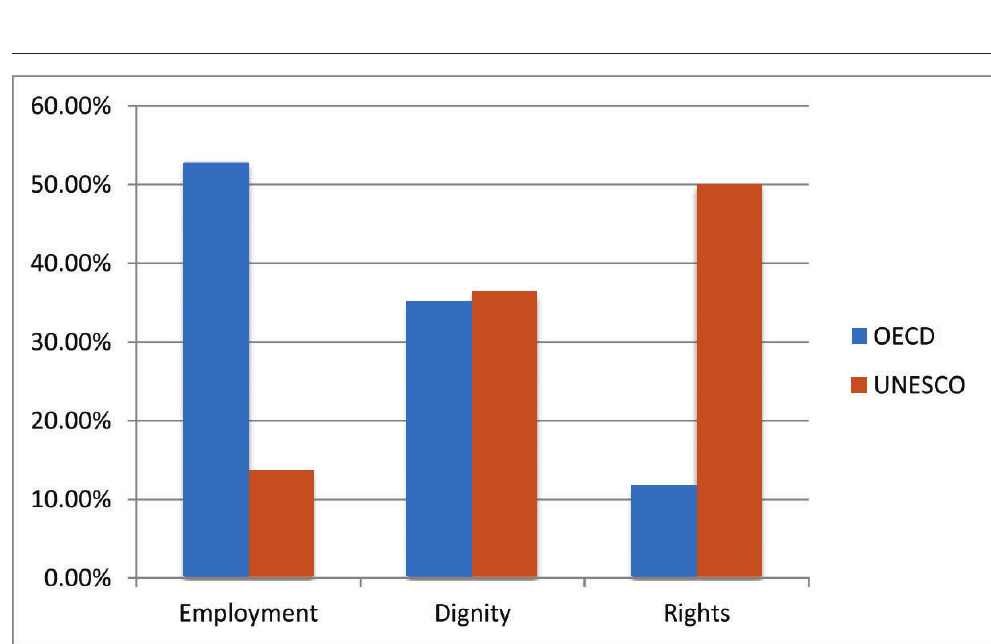
Figure 5: Comparison of OECD and UNESCO Cluster 1 codes